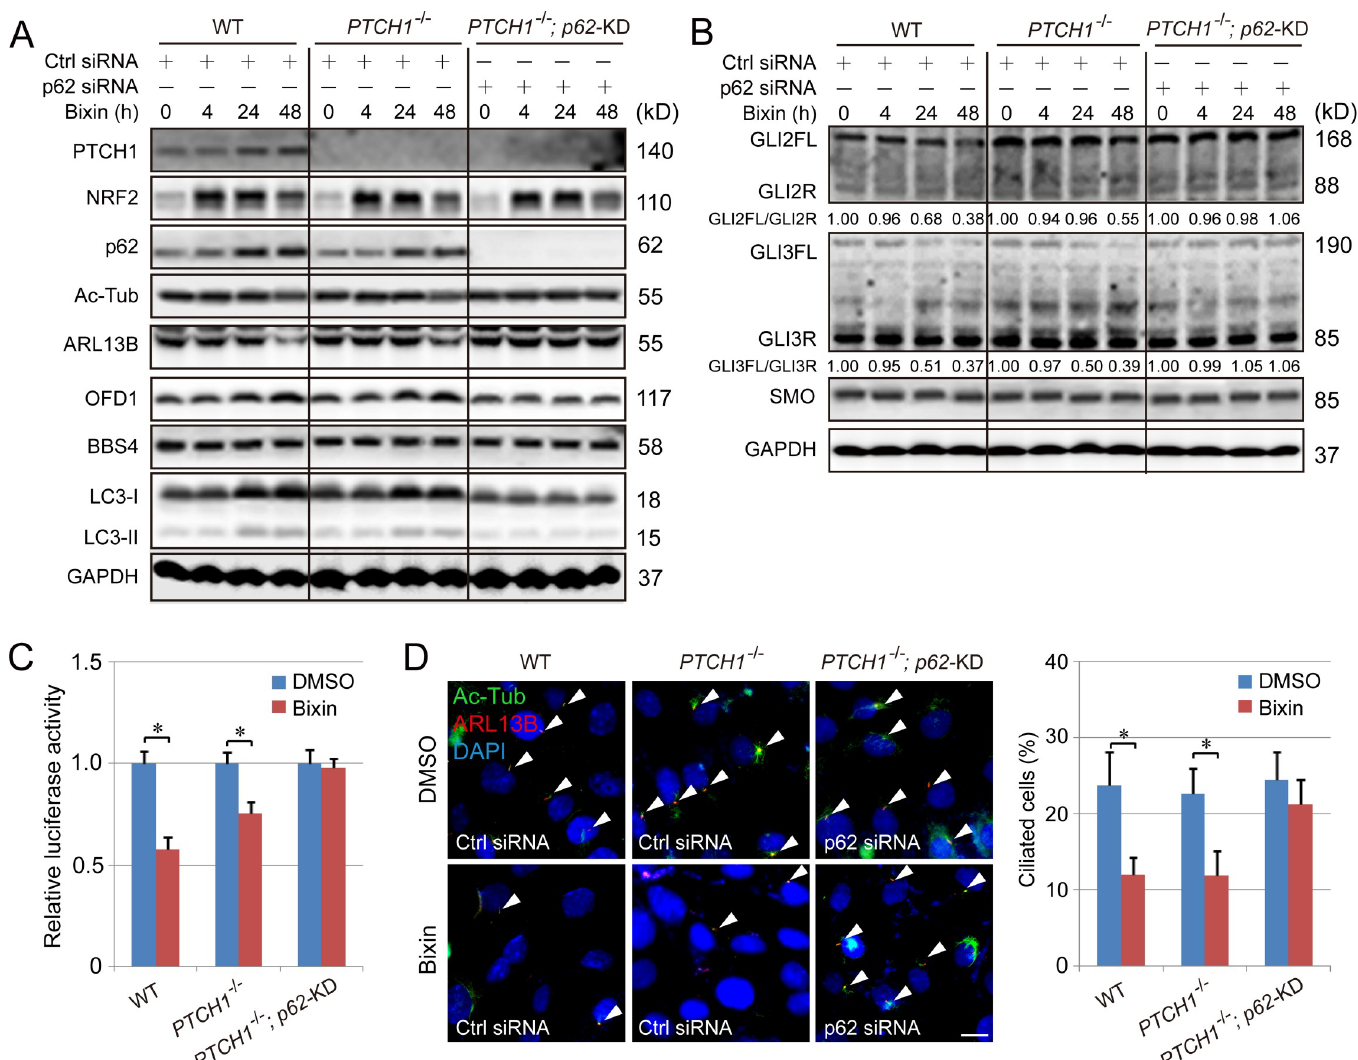
Fig 6. Hh signaling cannot be regulated by NRF2 in PTCH1 − / − ; p62 -knockdown cells. (A) Immunoblot analysis of PTCH1, NRF2, p62, Ac-Tub, ARL13B, LC3-I and II, OFD1, and BBS4 in WT, PTCH1 − / − , and PTCH1 − / − ; p62 -knockdown H1299 cells treated with bixin (40 μ M) for 0, 4, 24, or 48 h. Relative quantification of immunoblot results is shown in S10A Fig. (B) Immunoblot analysis of GLI2FL/R and GLI3FL/R, as well as SMO protein levels in WT, PTCH1 − / − and PTCH1 − / − ; p62 -knockdown H1299 cells treated with bixin (40 μ M) for 0, 4, 24, or 48 h. Relative quantification of immunoblot results is shown in S10B Fig. (C) GLI luciferase assay in WT, PTCH1 − / − , and PTCH1 − / − ; p62 -knockdown H1299 cells treated with bixin for 48 h. (D) Percent ciliated cells in WT, PTCH1 − / − , and PTCH1 − / − ; p62 -knockdown H1299 cells treated with bixin (40 μ M) for 48 hr. (Scale bar = 10 μ m.) Results are expressed as mean ± SD. A t test was used to compare the various groups, and p < 0.05 was considered statistically significant. � p < 0.05 compared between the two groups. Ac-Tub, acetylated tubulin; ARL13B, ADP-ribosylation factor-like protein 13B; BBS4, Bardet–Biedl syndrome 4; Hh, hedgehog; KD, knockdown; LC3, microtubule-associated proteins 1A/1B light chain 3B; NRF2, nuclear factor-erythroid 2-like 2; OFD1, oral–facial– digital syndrome 1; PTCH1, Patched 1; siRNA, small interfering RNA; SMO, smoothened; WT, wild type.